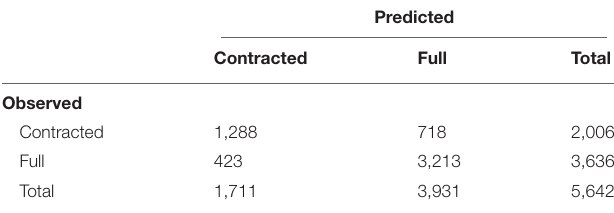
FIGURE 1 | Distribution of variants of post-NP has and is . TABLE 2 | Confusion matrix for is